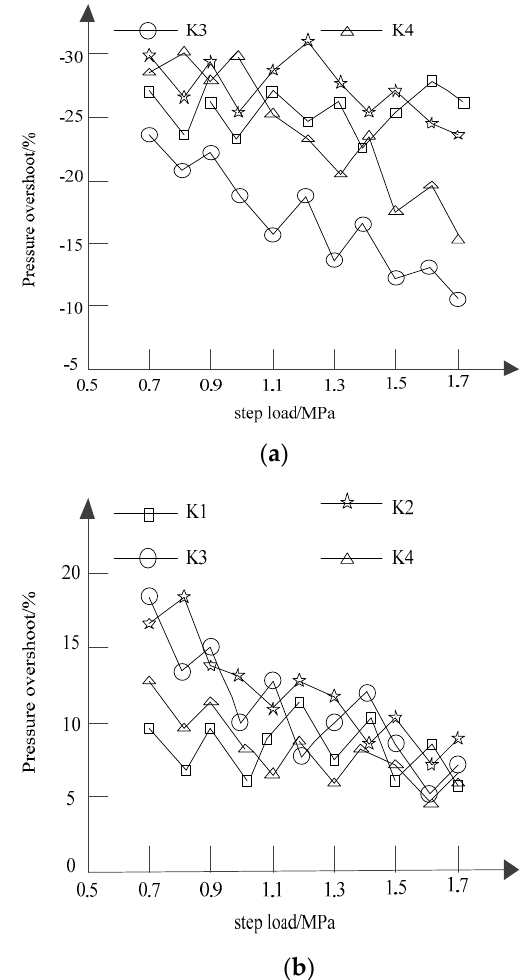
Figure 8. Variations of the overshoot of pressure in the rod cavity. ( a ) Loading of step load; ( b ) unloading of step load.